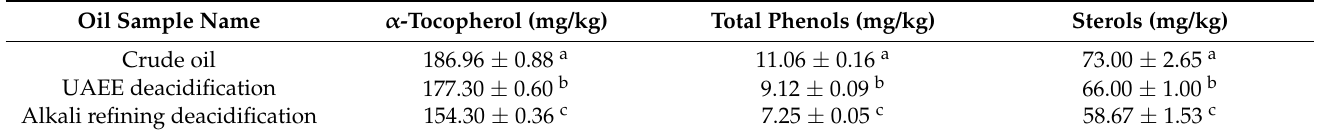
Table 5. Effects of different deacidification methods on lipid concomitant compounds of